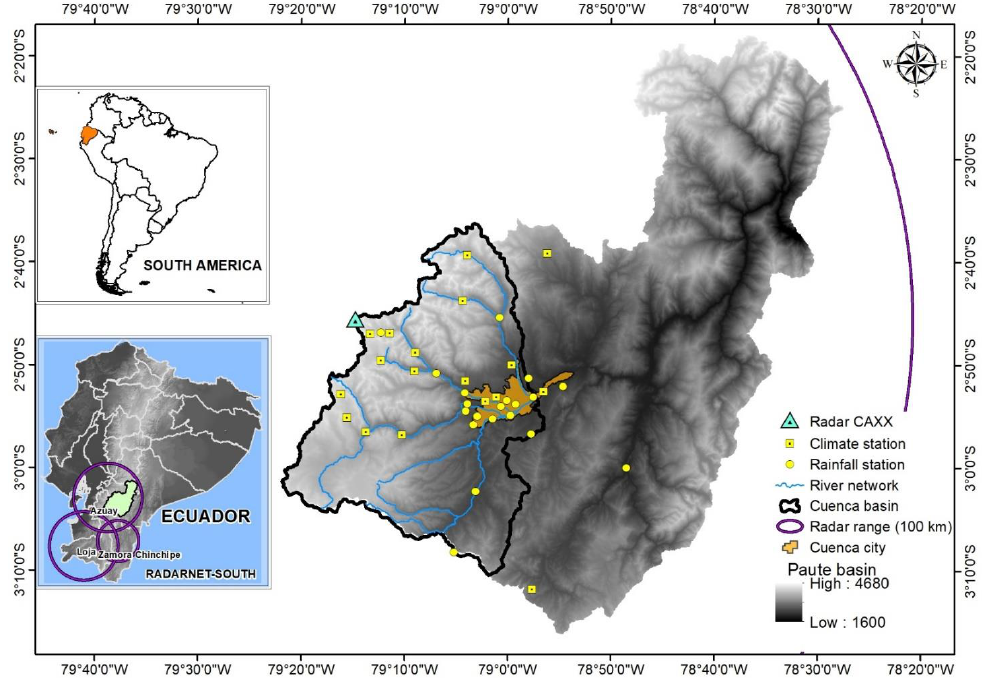
Figure 1. Study Area: Paute River basin, CAXX 100-km radar range, rain gauges, and climate stations. Lower left inset: radar network RadarNet-Sur.